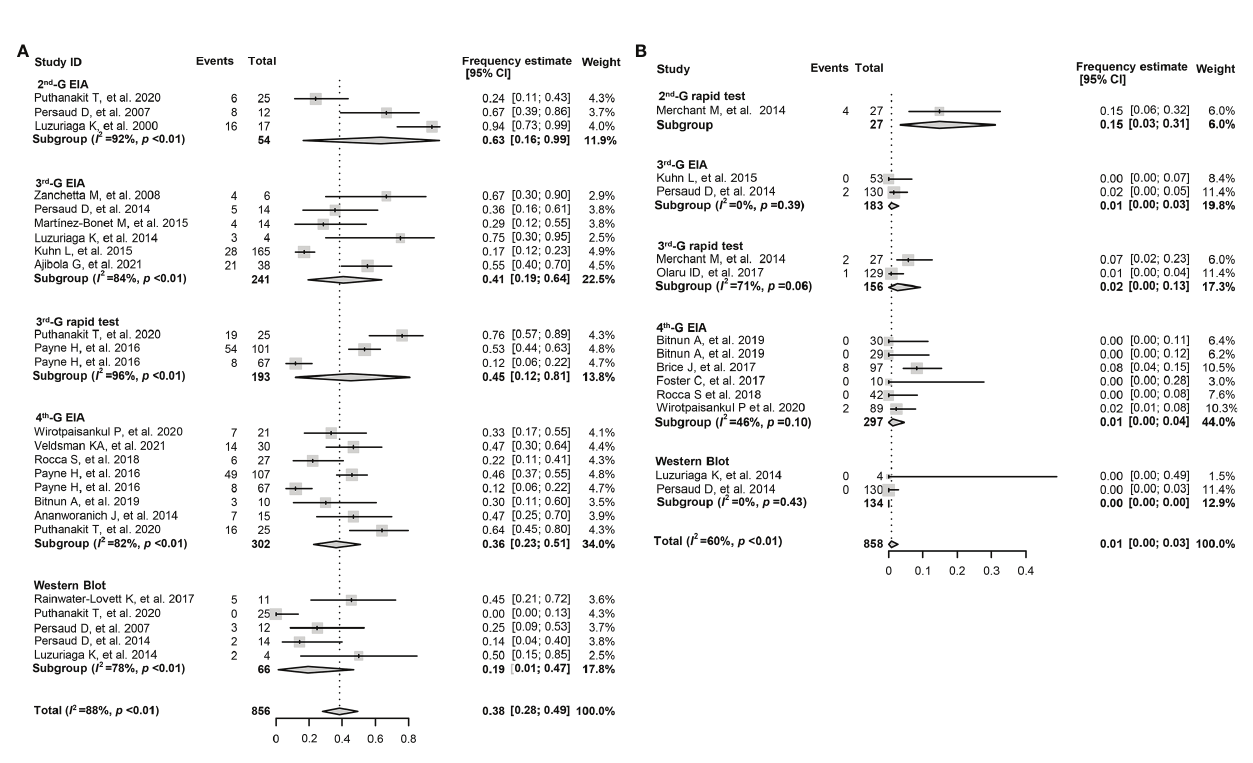
FIGURE 2 | Forest plots of the pooled frequency of HIV-1 seronegativity in HIV-infected children according to the principles of HIV-1 serological assays. (A) The pooled frequency of HIV-1 seronegativity in vertically HIV-infected children of ≥ 16 months old and cART started at the age of <6 months. (B) The pooled frequency of HIV-1 seronegativity in vertically HIV-infected children of ≥ 16 months old and cART started at the age of >6 months. 2nd-G EIA, second-generation enzyme immunoassay; 3rd-G EIA, third-generation enzyme immunoassay; 4th-G EIA, fourth-generation enzyme immunoassay; 2nd-G rapid test, rapid test based on second-generation principles; 3rd-G rapid test, rapid test based on third-generation principles; cART, combination antiretroviral